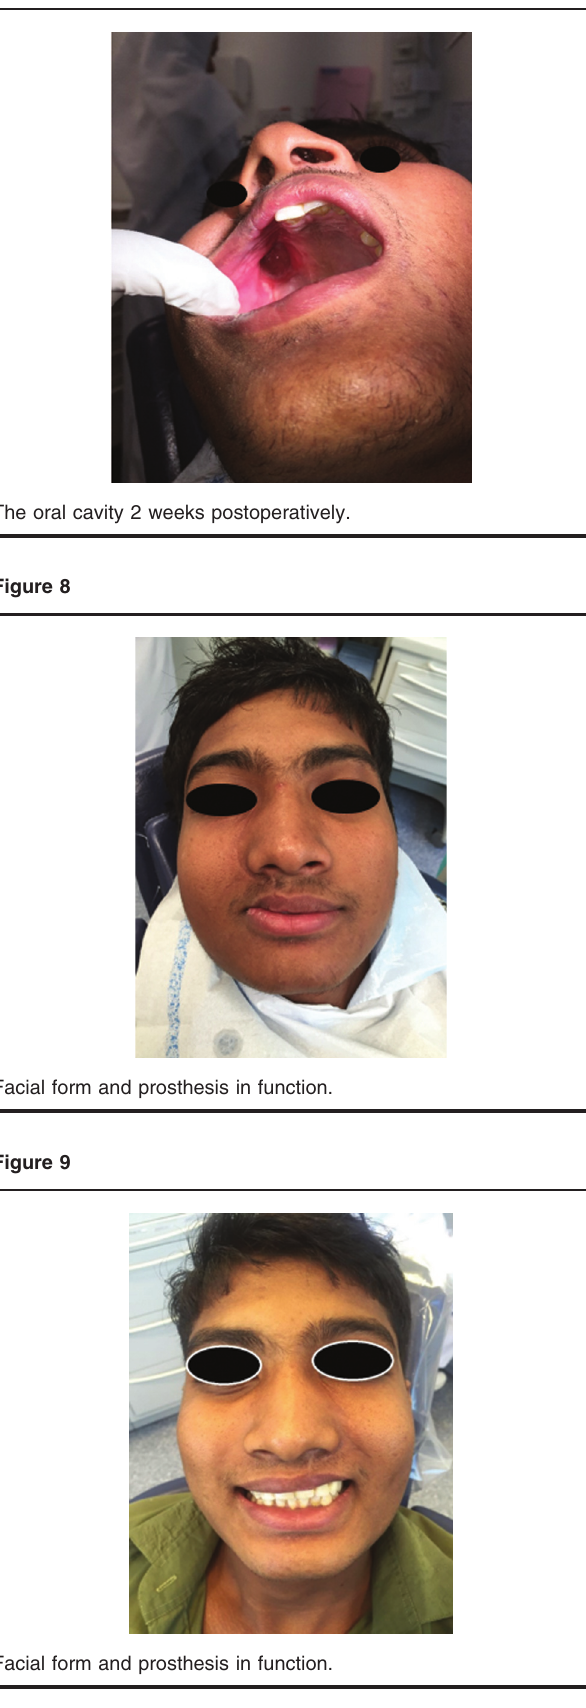
Facial form and prosthesis in